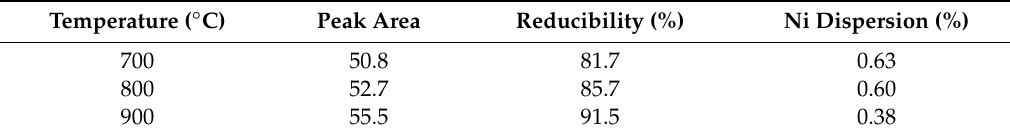
Table 4. Reducibility and Ni dispersion of Ni / Al 2 O 3 catalysts.